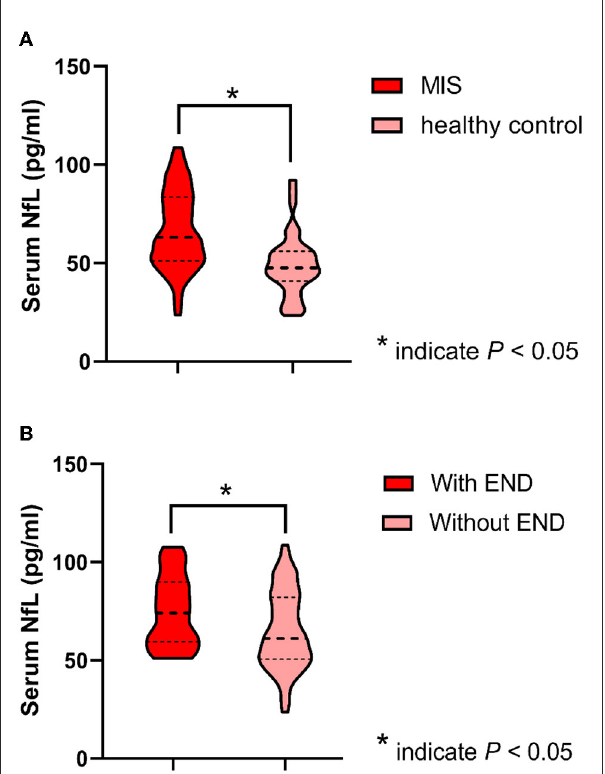
FIGURE3 Serum neurofilament light chain (sNfL) levels between groups. (A) sNfL levels between patients with minor ischemic stroke (MIS) and healthy controls are shown as violin plots (patients with MIS median: 63.1, IQR: 51.2–83.4 pg/ml vs. healthy controls median: 47.6, IQR: 40.8–56.1 pg/ml; p < 0.001). (B) sNfL levels between patients with MIS with END and without END are shown as violin plots (with END median: 74.1, IQR: 59.5–89.8 pg/ml vs. without END median: 61.2, IQR: 50.5–82.2 pg/ml; p =